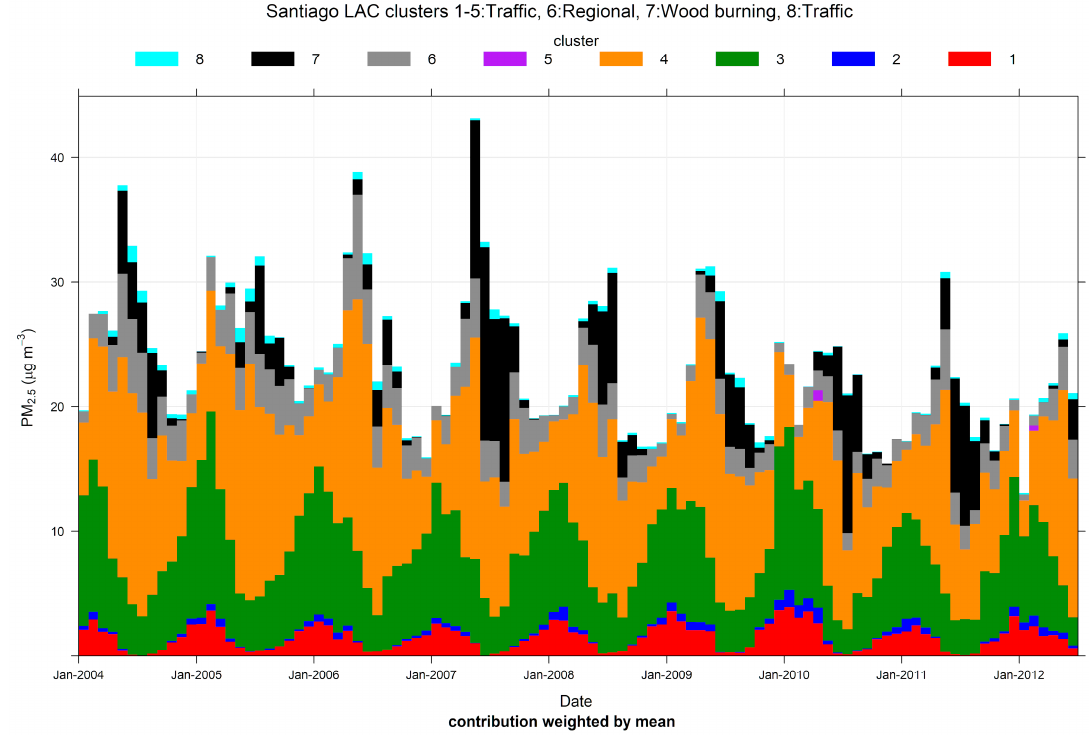
Figure 13. Cluster analysis source apportionment results for ambient PM 2.5 at Santiago, 2004/01–2012/06, for an eight-cluster solution.